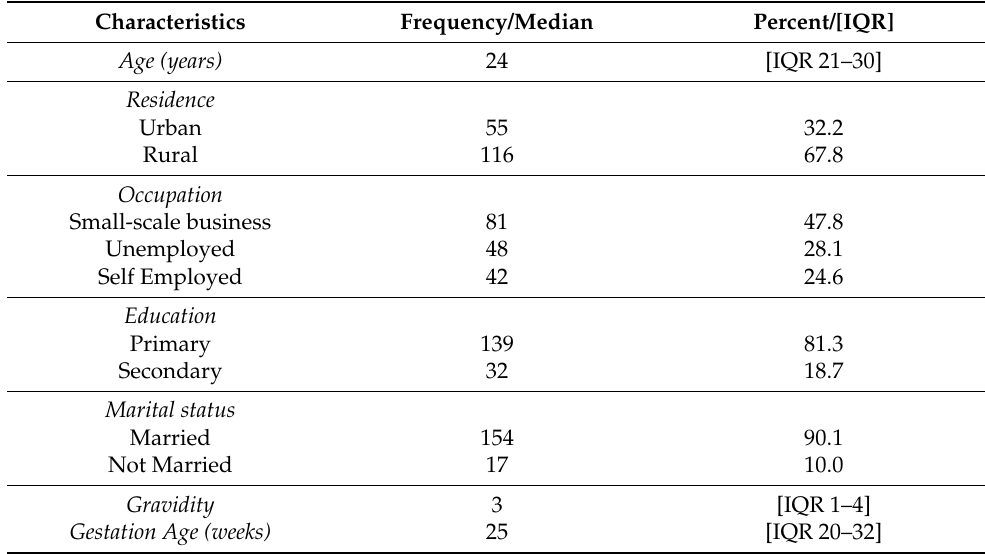
Table 1. Distribution of sociodemographic characteristics of the enrolled pregnant women in